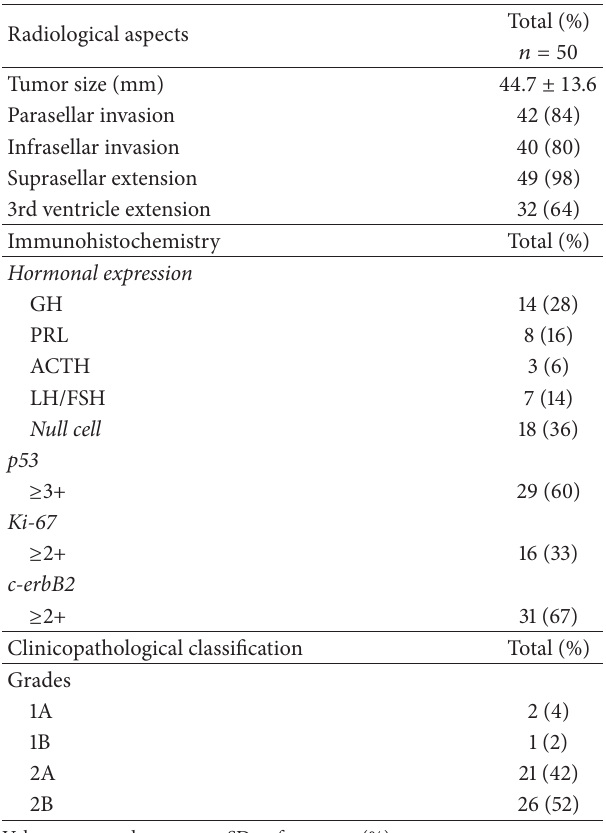
Table 2: Radiological and immunohistochemical characterization of tumors on